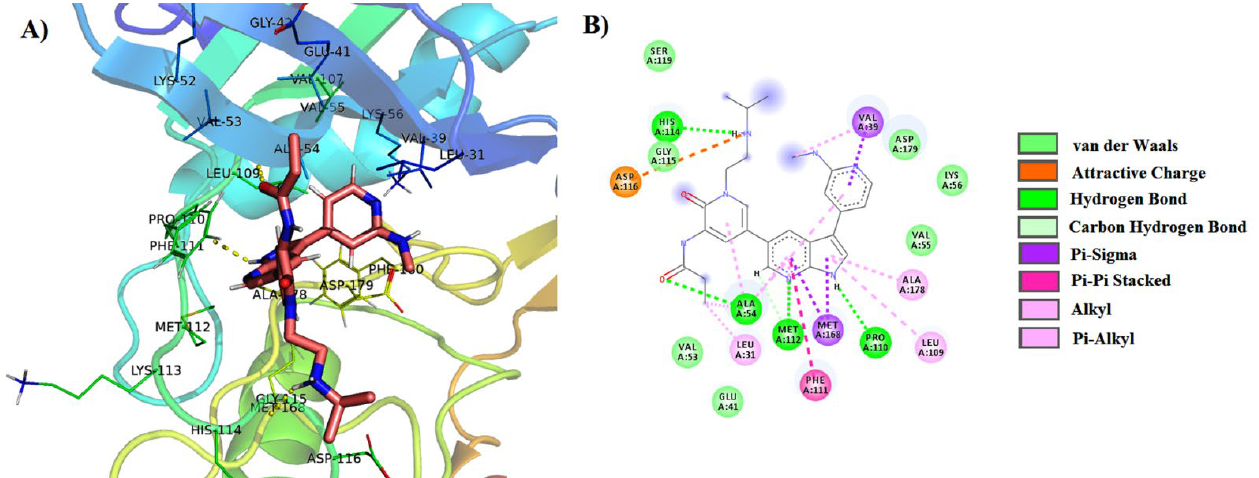
Figure 5. Plots generated from PubChem-122421875 bound AXL kinase based on 100 ns MD simula- tion trajectory ( A ) RMSD and ( B ) RMSF plots.